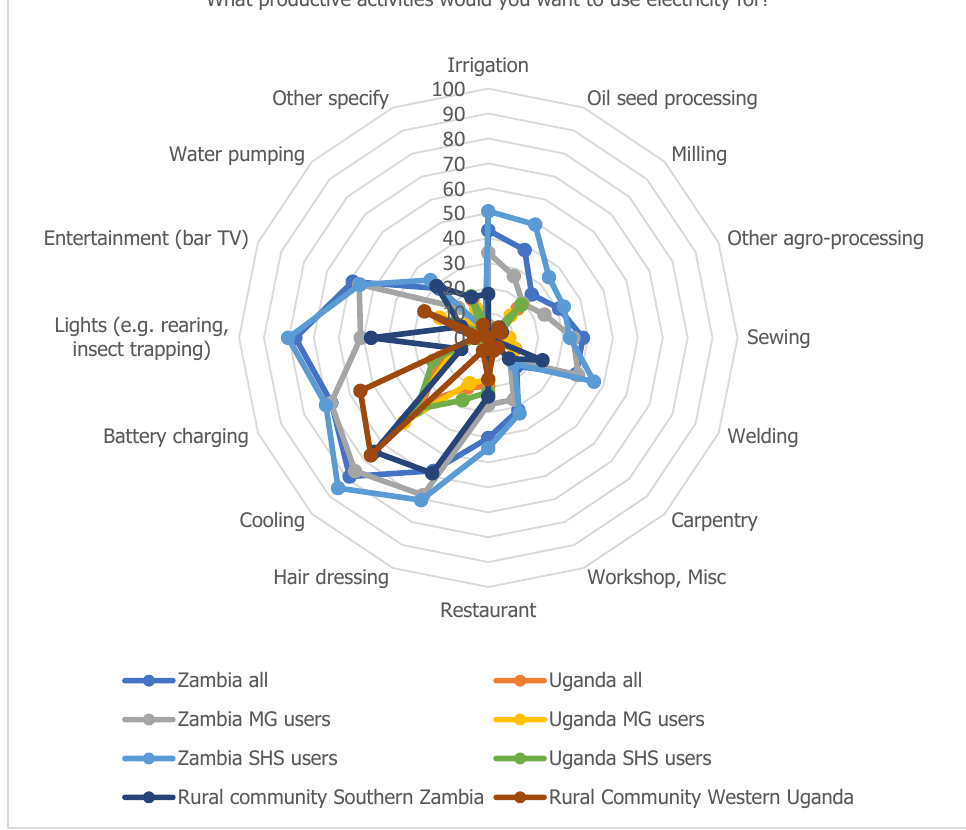
Figure 10. Type of desired productive uses in Uganda and Zambia (Responses in %; multiple responses; N = 1037).